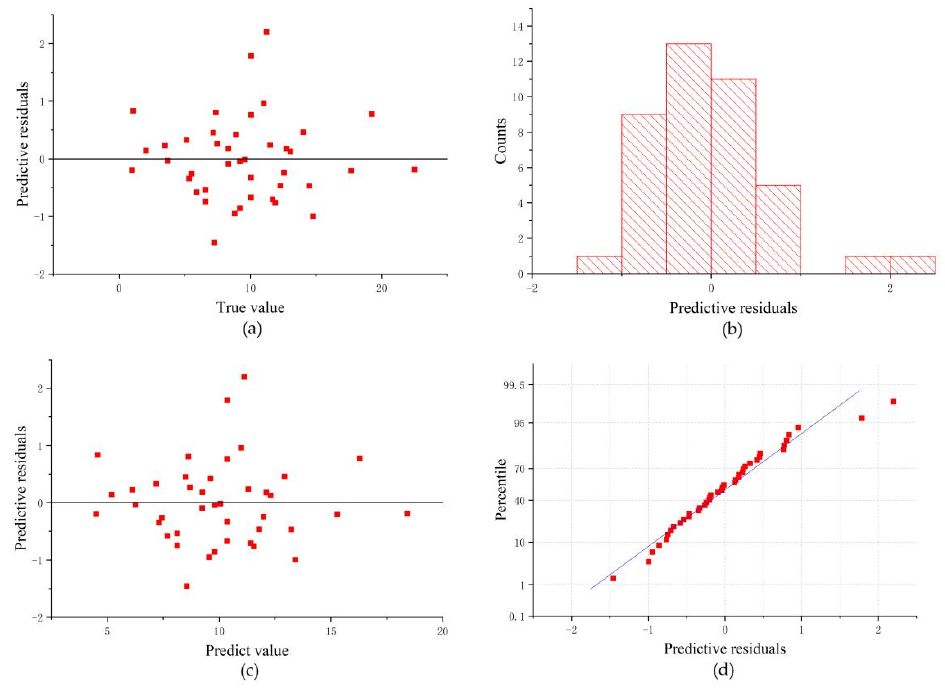
Figure 13. Coherent amplitude method with random forest estimation of height residuals: ( a ) pre- dicted residuals of true tree height; ( b ) the counts of predicted residuals; ( c ) predictive residuals of predicted value; ( d ) the percentile of predictive residuals.